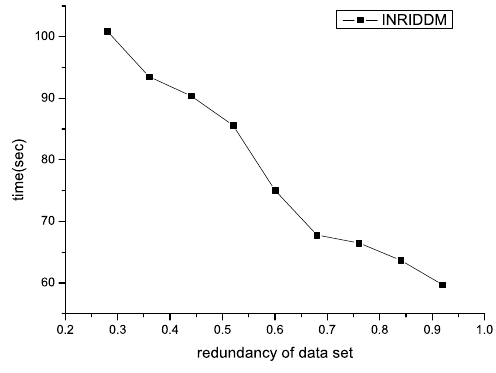
Fig. 2. The computation time(in seconds) of INRIDDM on saturated data sets and non-saturated data sets.